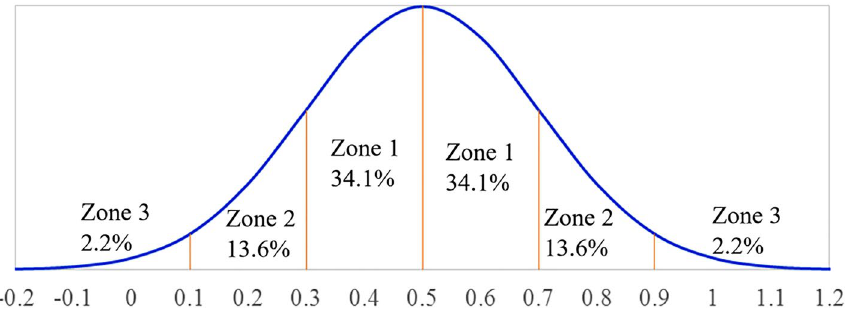
Figure 4. Gauss distribution.